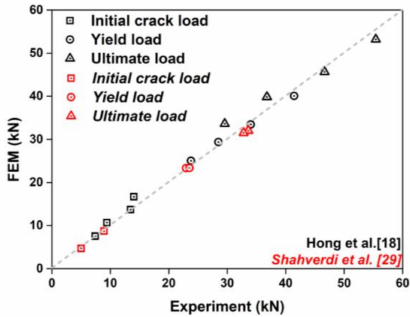
Figure 12. Comparison of experimental and numerical prediction